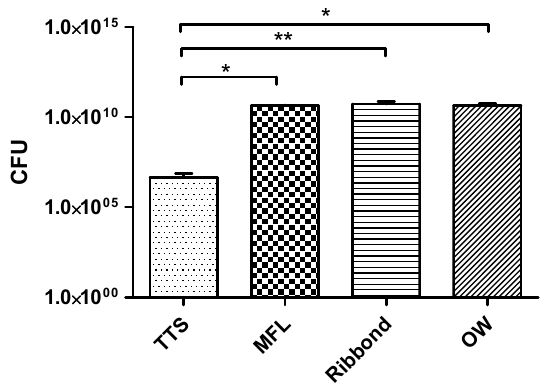
Figure 3. Colony forming unit values (CFUs) showing the number of viable cells in each sample. MFL: monofilament fishing line, OW: NiTi orthodontic wire, Ribbond: lock-stitch woven polyethylene ribbon, TTS: Titanium Trauma Splint. * p < 0.05, ** p <